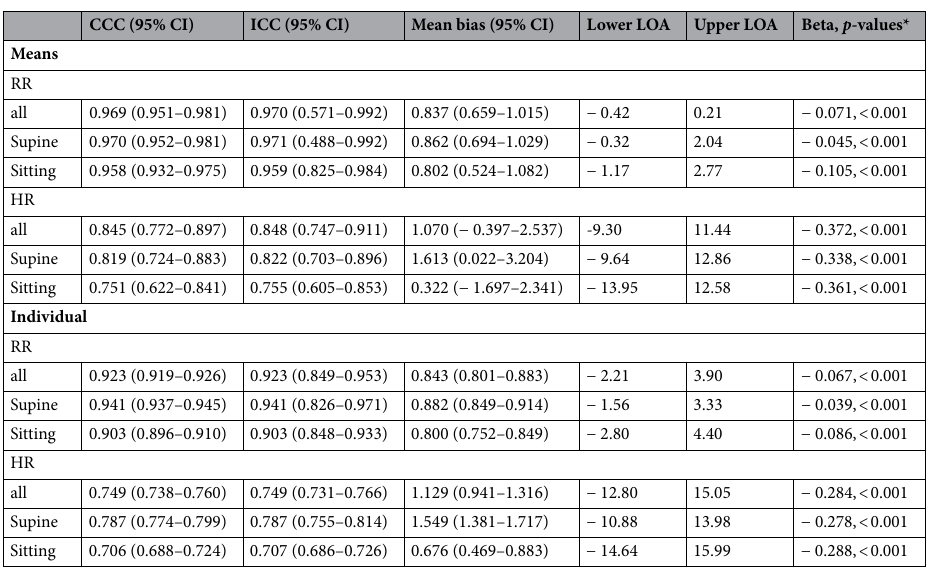
Table 2. Agreements of RR and HR between radar and the conventional monitor according to the postures. RR respiratory rate, HR heart rate, CCC concordance correlation coefficient, LOA limit of agreement. *Beta coefficients and p -values were derived from a linear regression analysis between the biases and the average between radar and the conventional